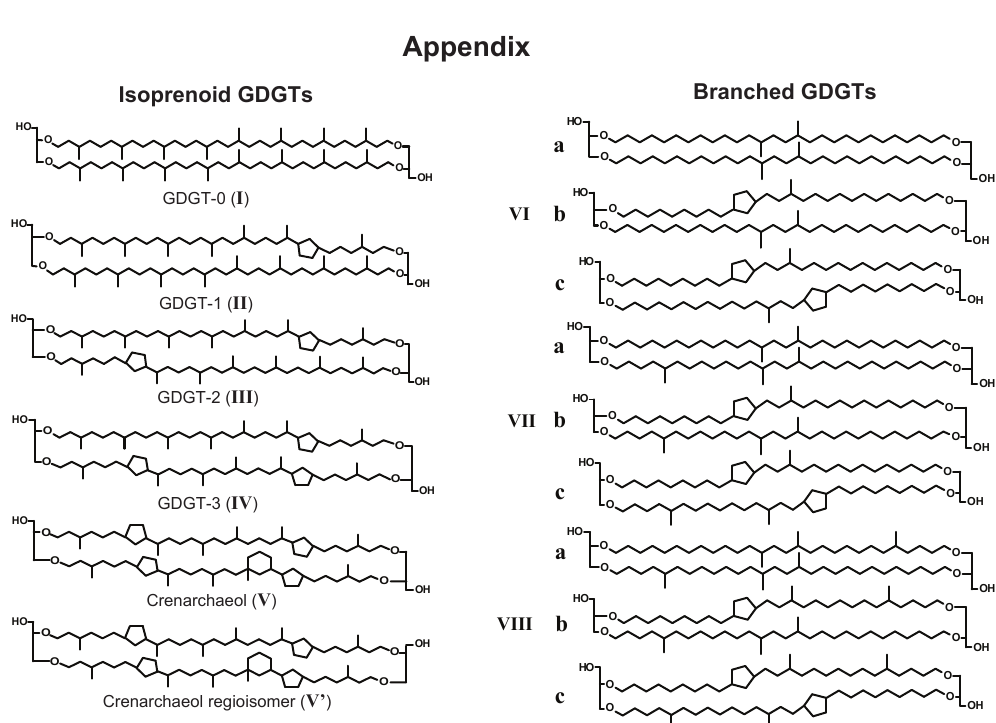
Figure A1. Key to GDGT structures. The number of cyclopentane moieties in the isoprenoid GDGTs is indicated by the number following GDGT as indicated. This is not used for crenarchaeol ( V ) and its regioisomer ( V (cid:48) ) since these GDGTs contain a cyclohexane ring. BrGDGTs are subdivided by their principal number of methyl substituents: four (VI), five (VII), or six (VIII). Each group consists of the parent brGDGT (a) and brGDGTs with one (b) or two (c) cyclopentane moieties formed by internal